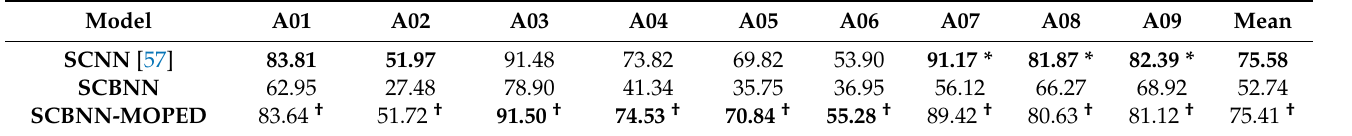
Table 2. Subject-specific classification results (% accuracy) on dataset